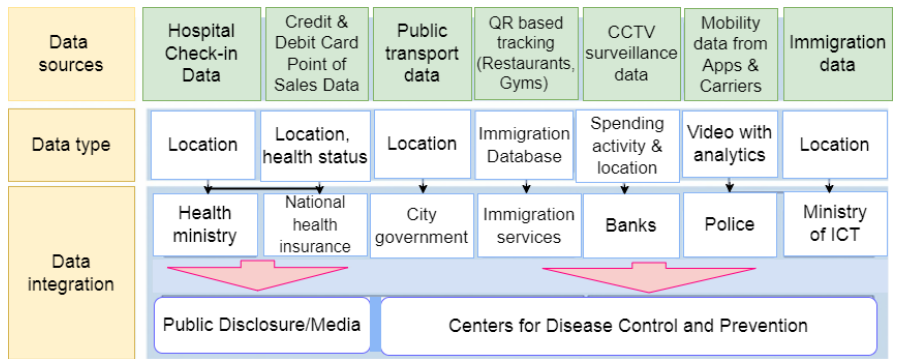
Figure 12. An Architecture of a Test and Trace